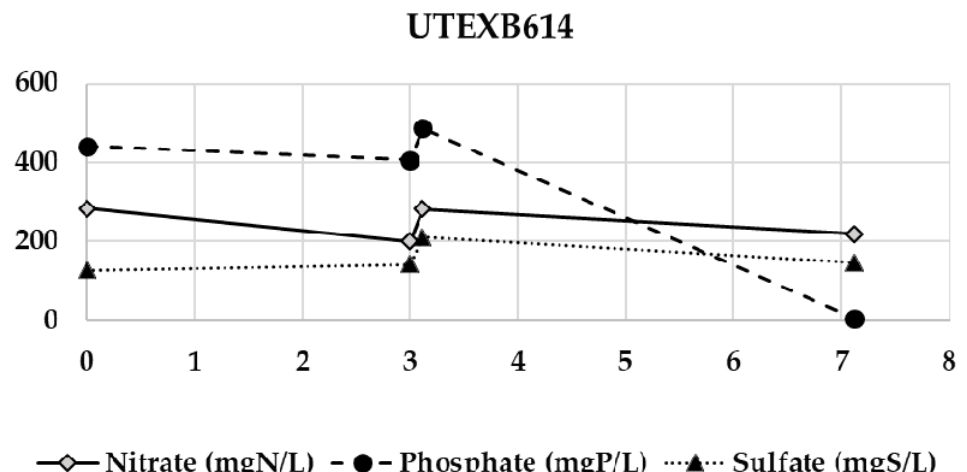
Figure A4. Evolution of the nitrate, phosphate, and sulfate concentrations during the semi-contin- uous test for UTEX393.